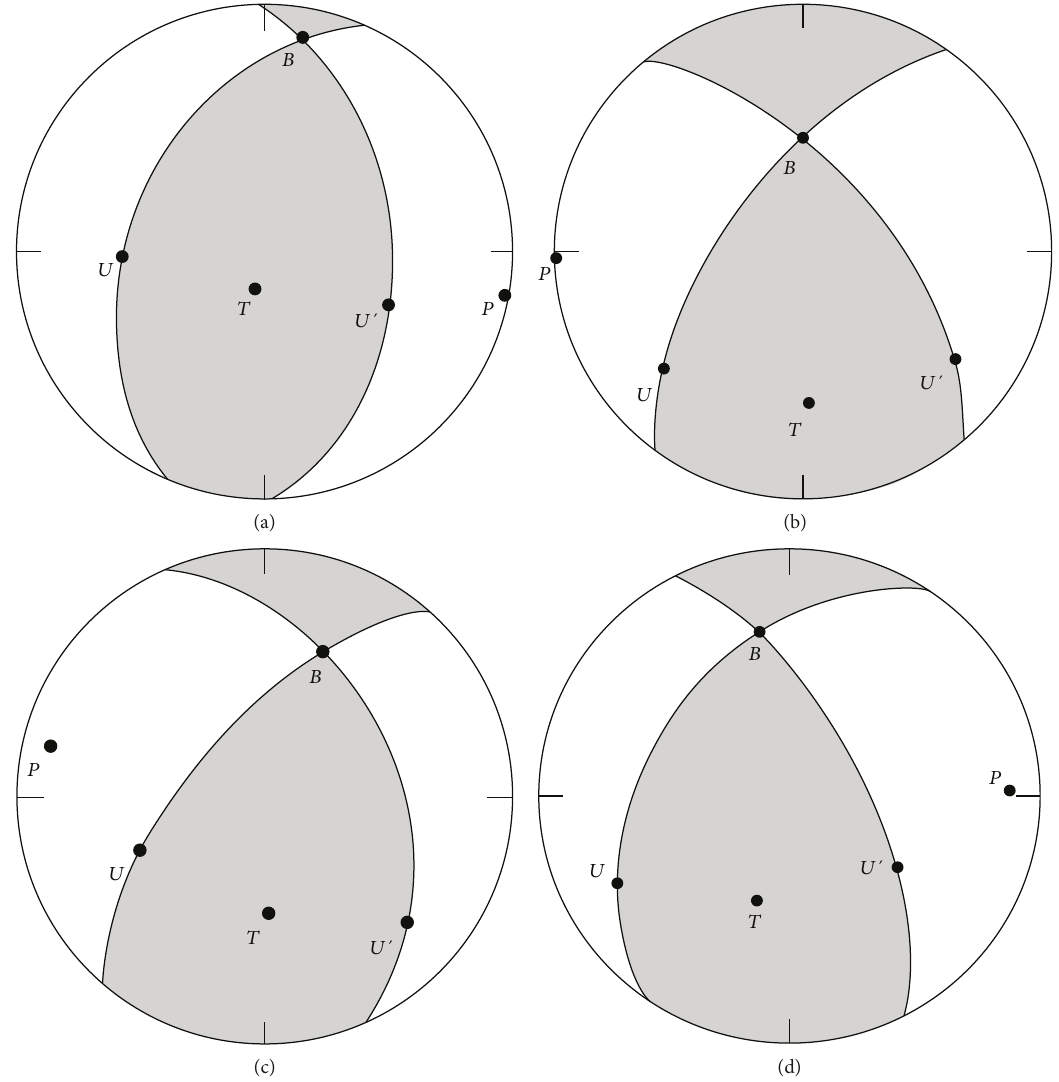
Figure 5: Four determinations of the focal mechanism of the Pohang mainshock. Diagrams are displayed as standard equal area projections of the lower focal hemisphere, with north at the top and compressional quadrants of the double-couple P-wave radiation pattern shaded. P , T , and B denote the P -axis, T -axis, and null axis, respectively; U denotes the slip vector, and U ′ denotes the direction perpendicular to the fault plane. (a) Determined by the U.S. Geological Survey [95]; (b) determined by Kim et al. [7]; (c) determined by Grigoli et al. [6]; (d) determined by Lee et al.